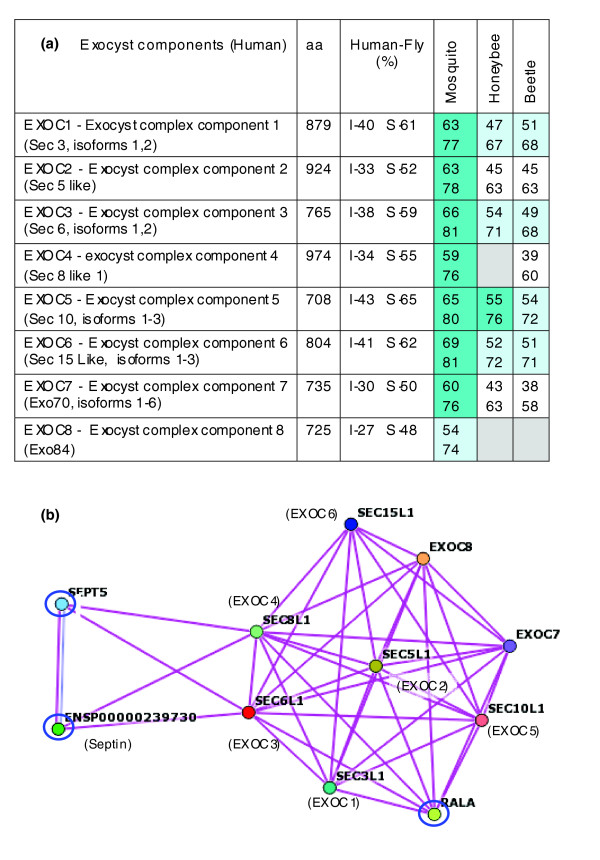
Exocyst protein interaction network in human and insects. (a) The subunits of mammalian exocyst (EXOC1 to EXOC8) and their yeast homologs (in parenthesis) are indicated. The percent of identity (I) and similarity (S) for human and the fly is shown. For mosquito, honeybee and beetle, the percentage identity and similarity (within each cell on top and bottom, respectively) relative to the D. malenogaster sequence are shown. Protein length is within 5% deviation between insect to their cognate human homolog. Dark blue background indicates similarity level above 75%, light blue indicates similarity above 65%, and white marks indicate similarity level below 64%. Gray background indicates that a homolog is missing. (b) Protein-protein interaction graph according to STRING tool (see Materials and methods). A tight interaction network extends from the exocyst to other partners (circled in blue) of small GTPase, RalA, and septin. aa, amino acids.